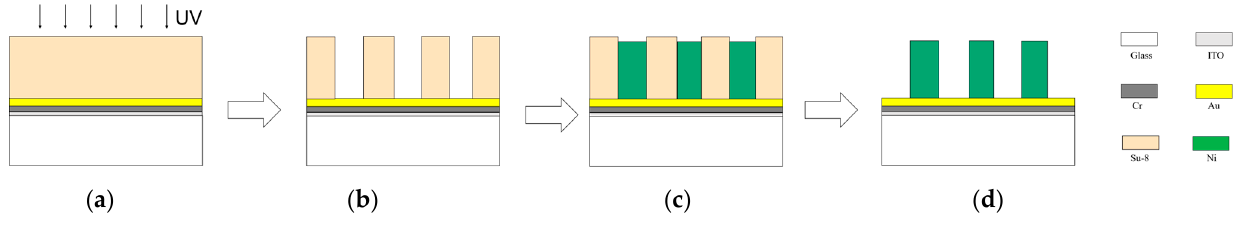
Figure 3. Fabrication processes of microstructure in the traditional fabrication method. ( a ) Cr/Au seed layer, spin SU-8 and front lithography; ( b ) development; ( c ) electroforming; ( d ) removal of the SU-8 photoresist.